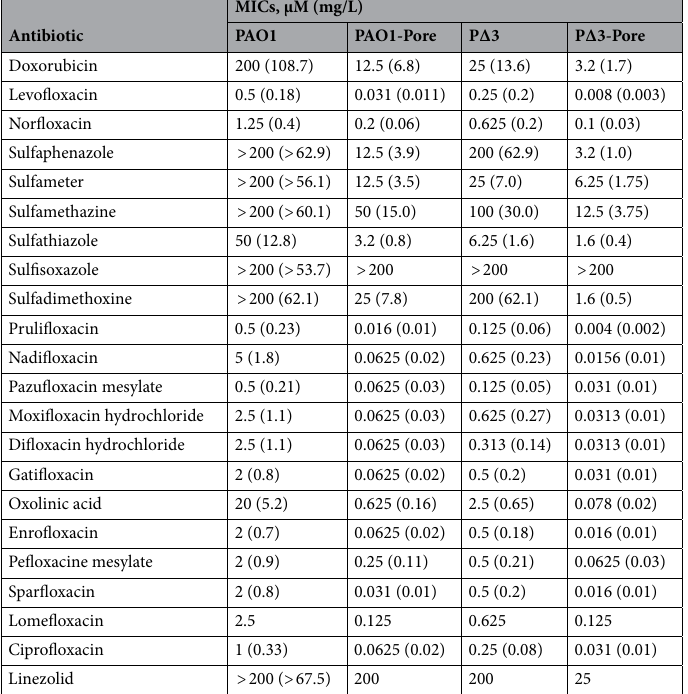
Table 2. MICs of antibiotics analyzed by LC–MS in four strains of P. aeruginosa grown in MOPS-M9 medium